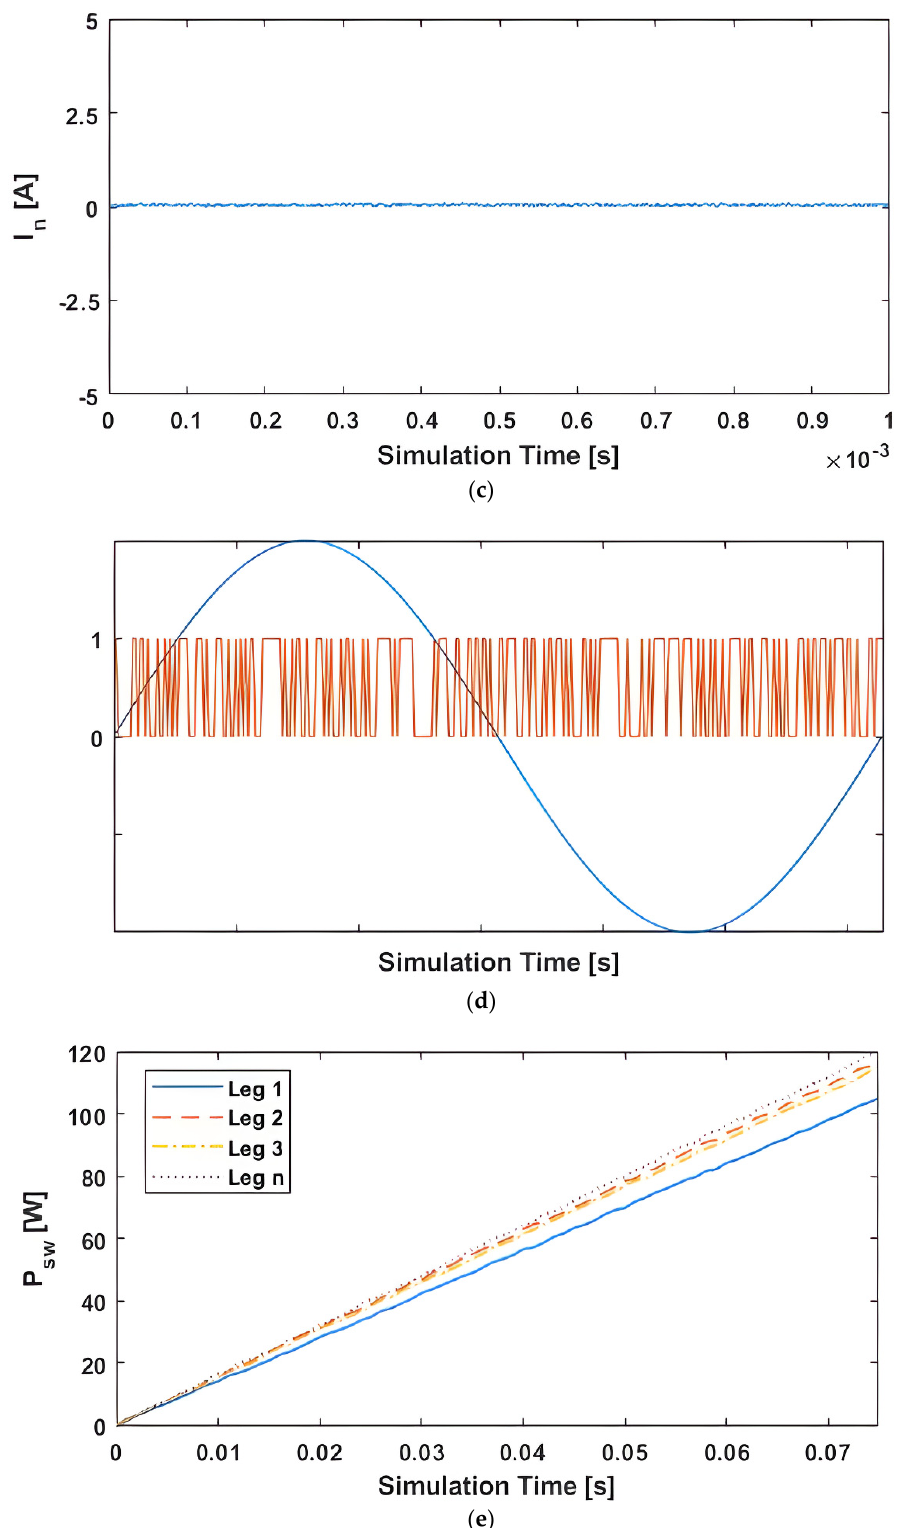
Figure 3. ( a ) V abc -Mode I with Balanced Reference Currents. ( b ) I abc -Mode I with Balanced Reference Currents. ( c ) I n -Mode I with Balanced Reference Currents. ( d ) Switching frequency for one duty cycle-Mode I with Balanced Reference Currents. ( e ) Switching losses-Mode I with Balanced Reference